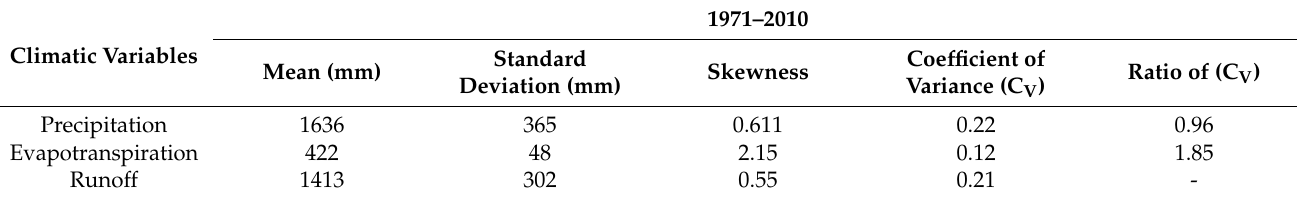
Table 4. Statistical indices for annual variations in precipitation, evapotranspiration, and runoff of the KRB.